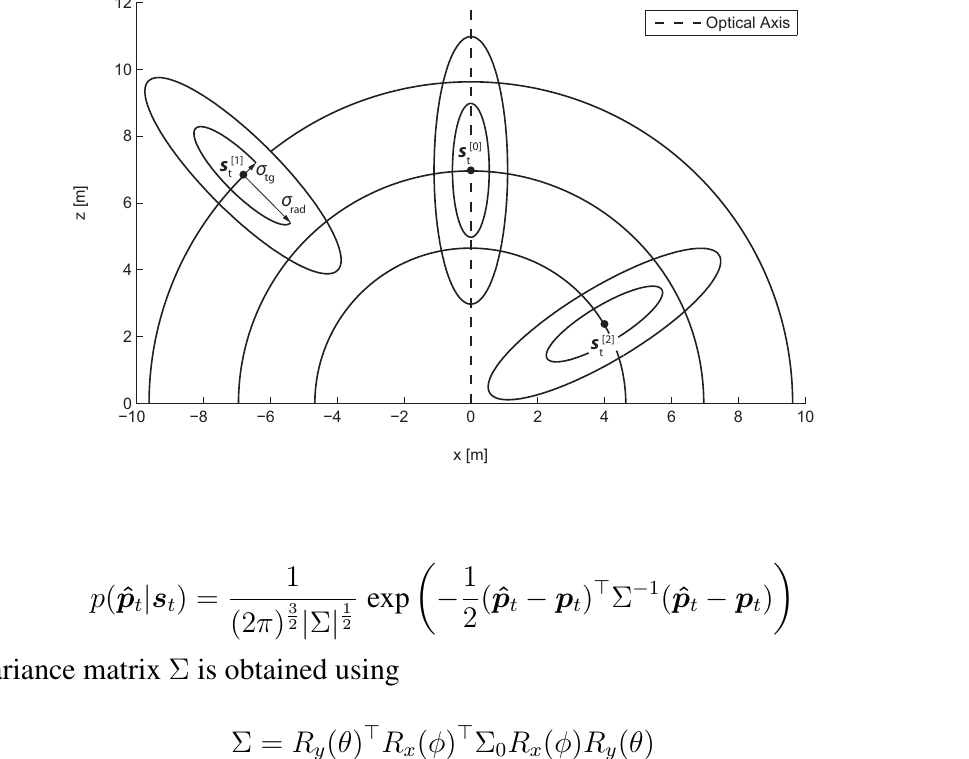
Figure 9. 2D projection of the characteristic 3D measurement probability p ( ˆ p different example states s [0] The measurement probability is modeled by a multivariate normal distribution with specific standard deviations σ one and two